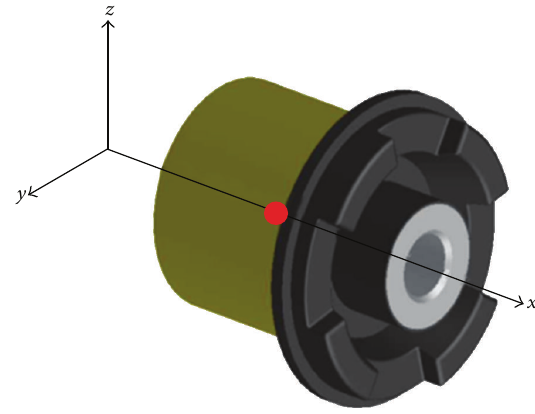
Figure 2: CAD model of rubber bushing.